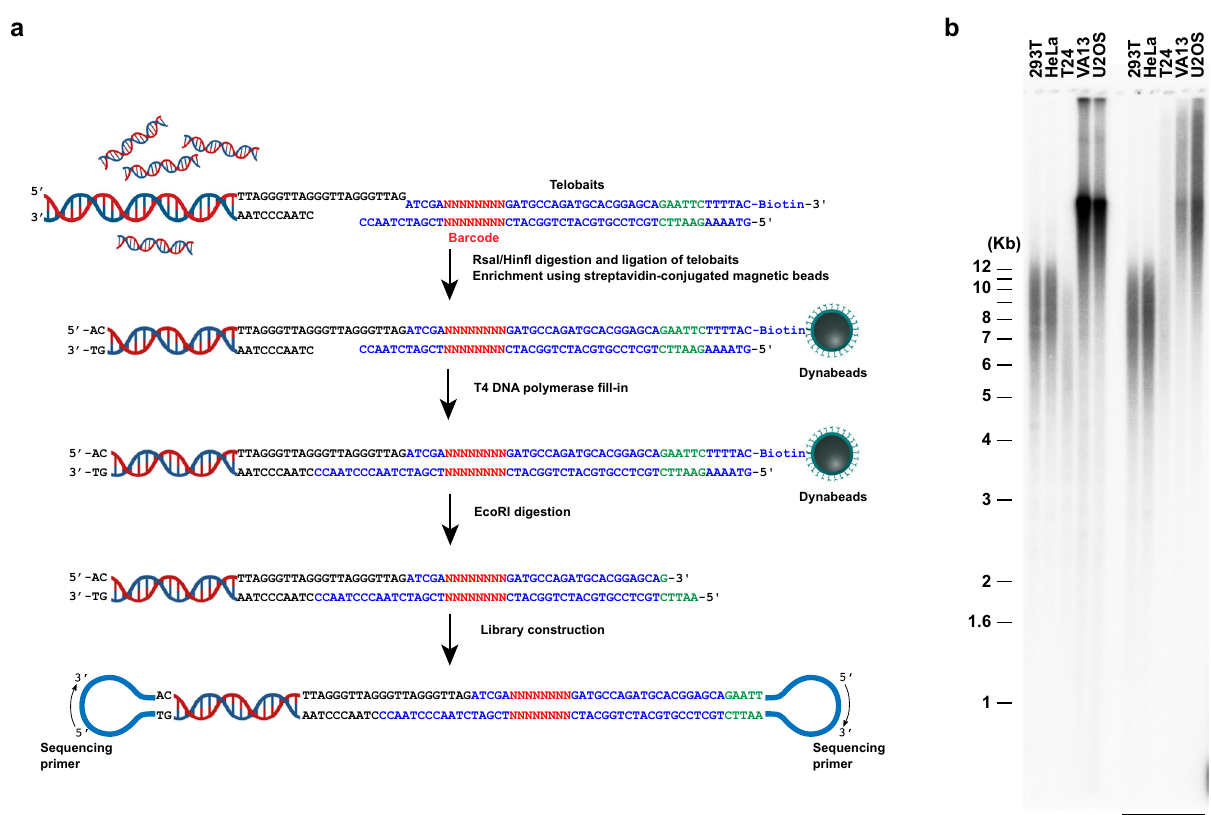
Fig. 1 | Enrichment of telomere-containing genomic DNA fragments using tel- obaitsforPacBioHiFisequencing.a Schematicillustrationof thekeystepsinthe enrichmentoftelomererepeat-containinggenomicDNAfragmentsforPacBioHiFi sequencing. b Teloblotresultsshowingthatthetelomere-containinggenomicDNA fragments enriched following telobaits ligation (without trimming using RsaI and